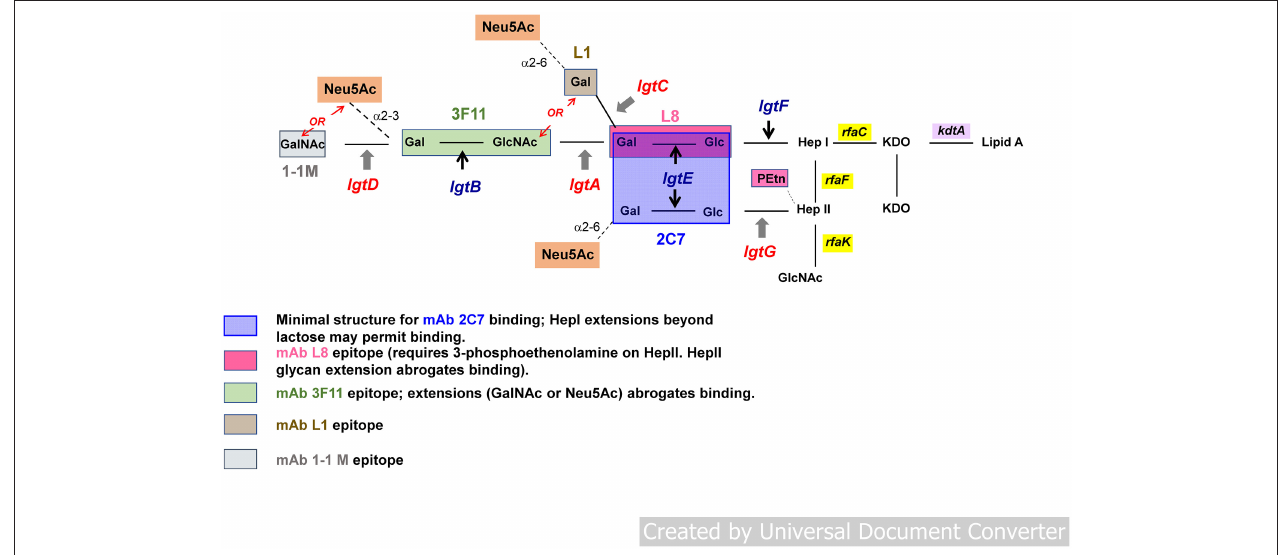
FIGURE 1 | General structure of gonococcal lipooligosaccharide (LOS). Gonococcal LOS consists of three oligosaccharide (OS) chains. The OS chains branch from two heptose residues attached to lipid A via two 2-keto-3-deoxy-mannooctulosonic acid (KDO) molecules. One OS chain elongates from the first heptose (Hep I) outward; two chains extend from the second heptose (Hep II). Lacto- N -neotetraose structure (Gal β 1-4GlcNAc β 1-3Gal β 1-4Glc β 1-4-) or P k (Gal α 1-4Gal β 1-4Glc β 1-4-) extend outward from Hep I. Phase variable genes involved in LOS biosynthesis ( lgtA, C, D, and G ) are shown in red; non-variable genes ( lgtF , lgtE, and B ) in blue. Neu5Ac (sialic acid) is shown in the orange boxes. Sialylation of LOS occurs via α 2-6 or α 2-3 linkage to galactose (Gal) residues. LOS branching is terminated (“capped”) either by Neu5Ac (sialic acid) or otherwise extend(s) outward by adding hexose(s). LOS epitopes are defined by mAbs 2C7, L8, 3F11, L1, and 1-1M.